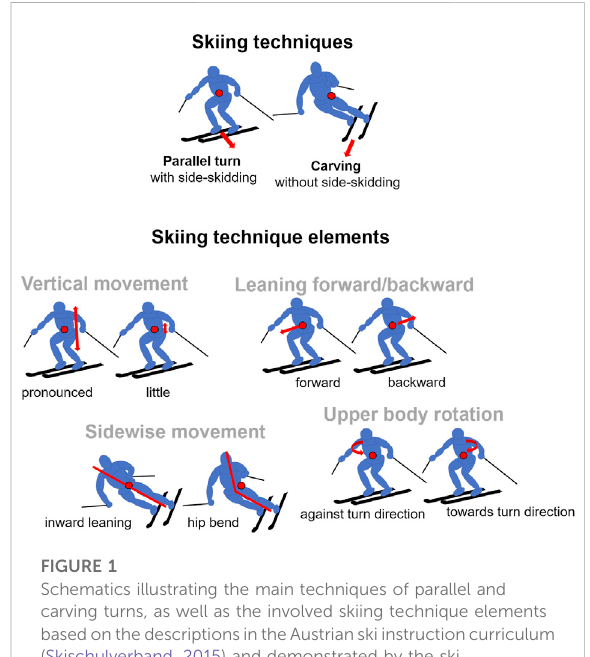
FIGURE 1 Schematics illustrating the main techniques of parallel and carving turns, as well as the involved skiing technique elements basedonthedescriptionsintheAustrianskiinstructioncurriculum (Skischulverband, 2015) and demonstrated by the ski instructors within the